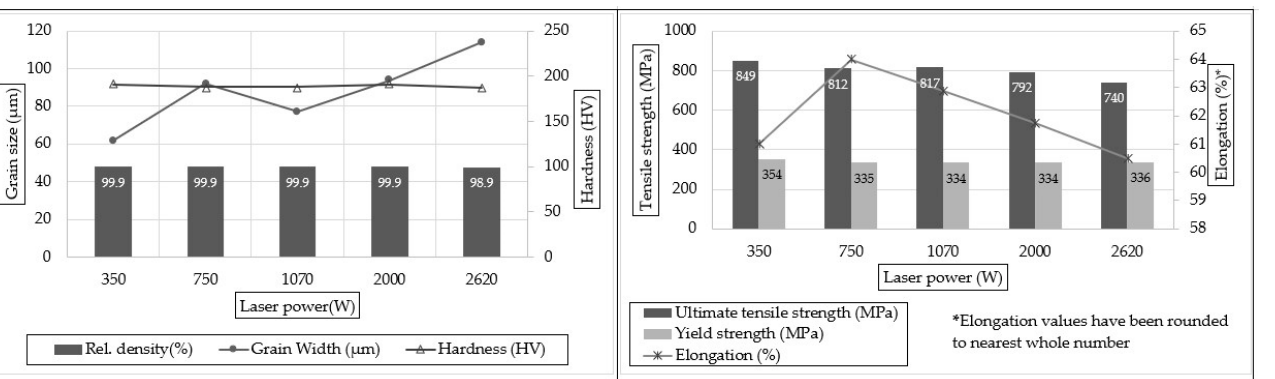
Figure 9. E ff ect of laser power on grain size and tensile mechanical properties (data from Ref. [37]).